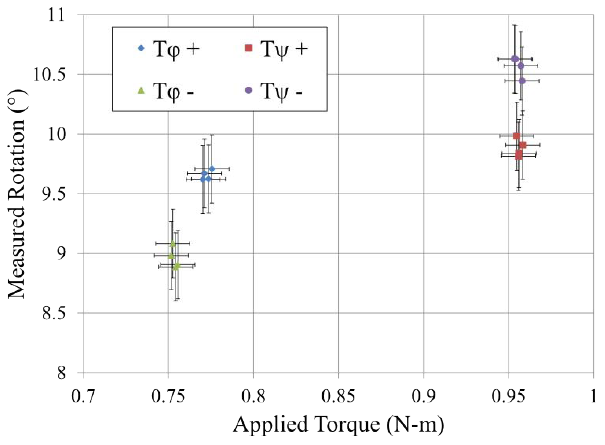
Figure 13. Measured rotation for applied torques T φ and T ψ at ψ = 0 and φ = 0, respectively. All data are absolute values with the sign indicated by the legend. Data is for the titanium prototype.